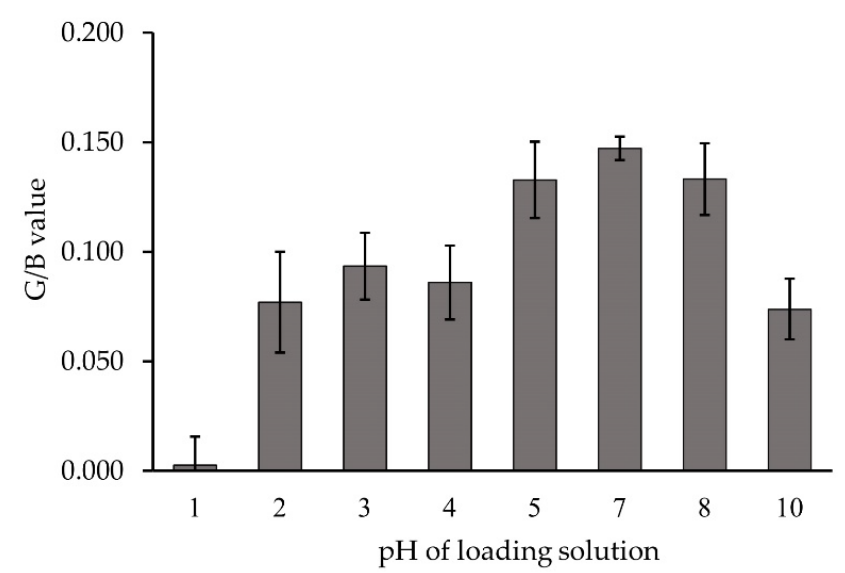
Figure 5. Effect due to pH of loading solution (see text in Table 1).